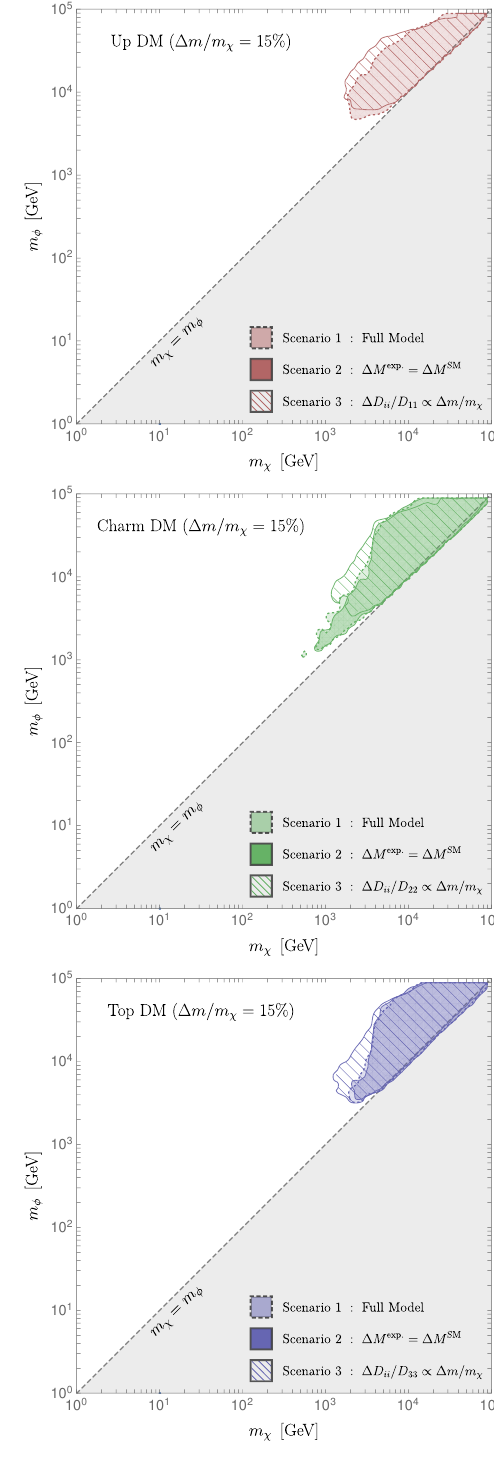
Figure 17 . Comparison between 2 (cid:27) contours of the full MCMC scan and two extensions discussed in the text, for a mass splitting of 2 % (left) or 15 %